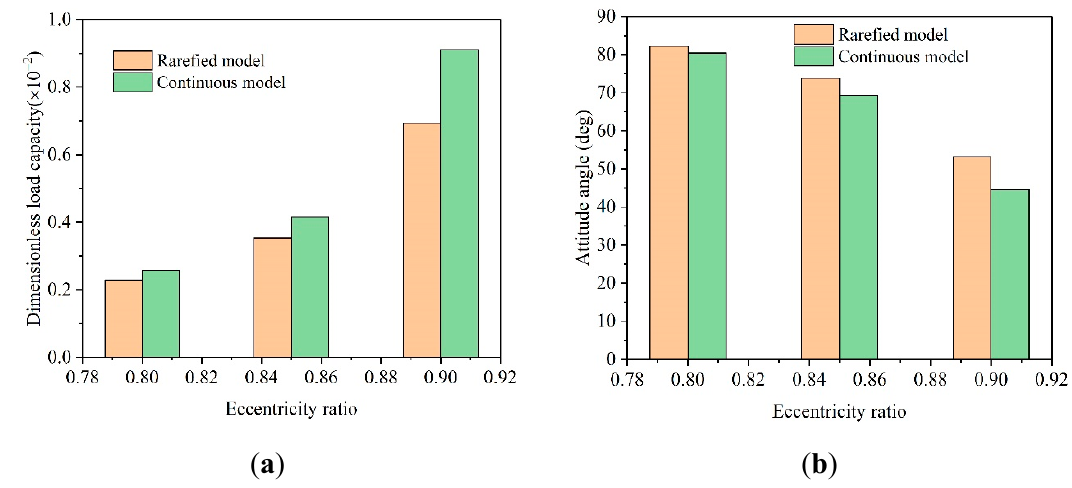
Figure 4. Static performances comparison between two calculation models ( a ) variation of dimensionless load capacity with eccentricity ratio; ( b ) variation of attitude angle with eccentricity ratio.